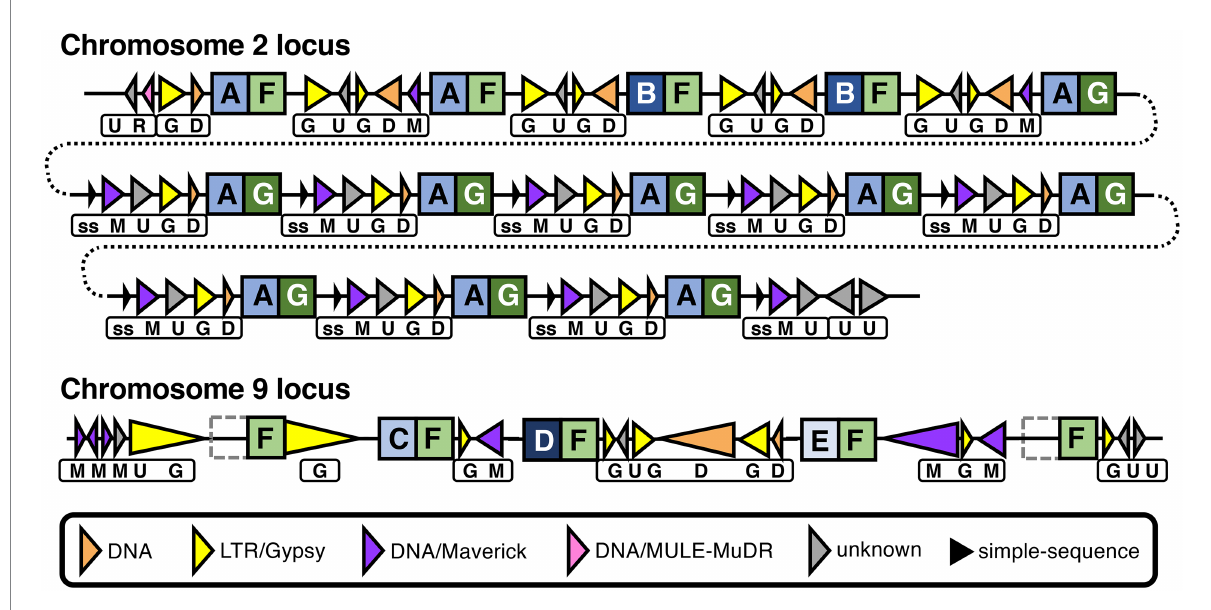
FIGURE 7 Recombination and repeats in two CRN gene clusters in the Phytophthora agathidicida genome. Genomic organization of CRN gene repeat clusters on chromosomes 2 and 9. CRN genes are indicated by square boxes with letters inside. N and C termini of predicted CRN proteins are indicated by blue and green boxes, respectively, with different shading and letters indicating different variants. Repeats are indicated by triangles, with transposons depicted as colored triangles and simple-sequence (ss) repeats as smaller, black triangles, as shown in the key. Triangle direction refers to the strand each repeat is encoded on. The different combinations of repeats between CRN genes are also indicated beneath by boxes with letters. The chromosome 2 cluster is shown over multiple lines (joined by dotted lines) for ease of visualization. In the chromosome 9 cluster, the left- and right-most CRN genes both encode proteins that lack the N-terminal domain, as indicated by grey dotted boxes. Diagram is not to scale, although large differences in repeat length are indicated schematically by small differences in triangle